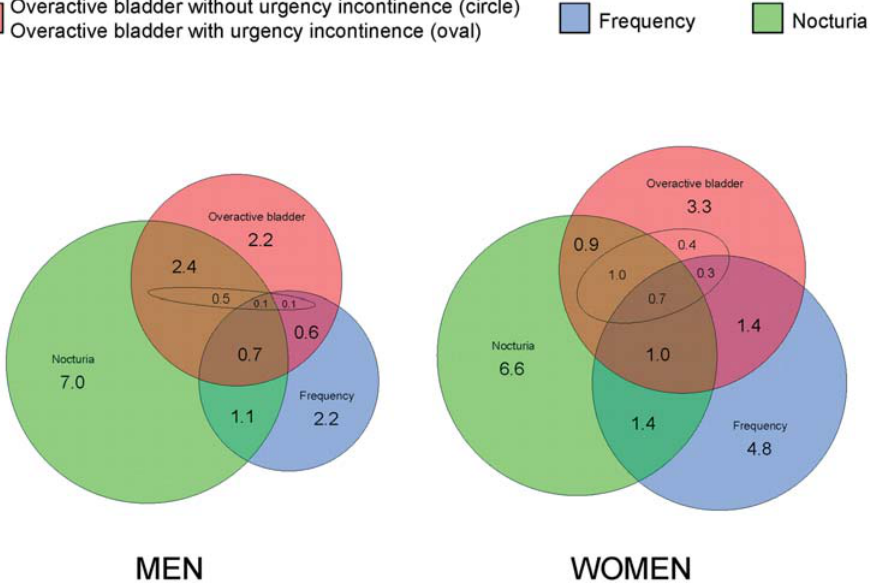
Figure 3. Age-standardized prevalence of overactive bladder symptoms among Finnish people aged 18–79 years, 2003–2004. The red circle represents subjects with overactive bladder without urgency incontinence excluding the area of the red oval representing subjects with overactive bladder with urgency incontinence. The blue circle represents subjects with urinary frequency (defined as more than eight voids per day) and the green circle nocturia (defined as more than one void per night). Age-standardization was performed using the general population [21].